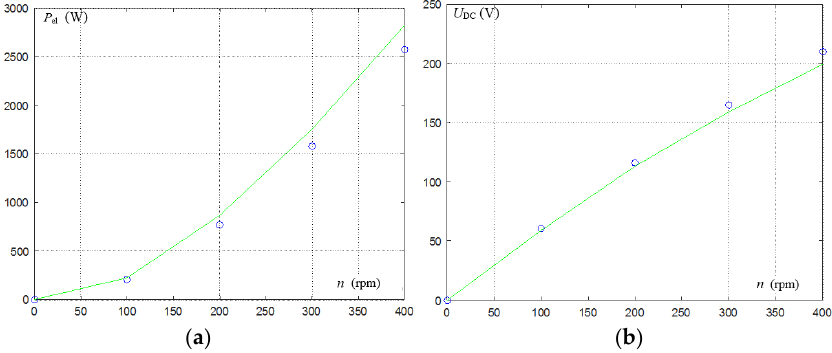
Figure 26. Generator G1: ( a ) voltage changes with the rectifier load; ( b ) electric power changes with rectifier load; for selected rotational speed values, points-measurement results, solid line-analytical calculations. •